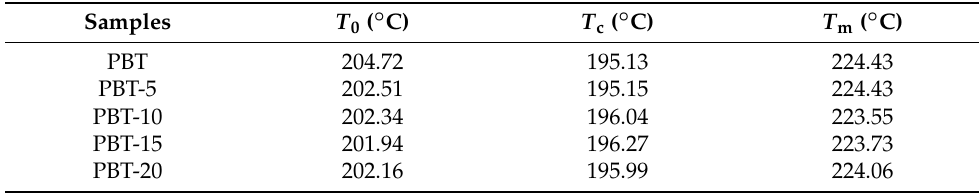
Table 2. The thermal parameters from the DSC